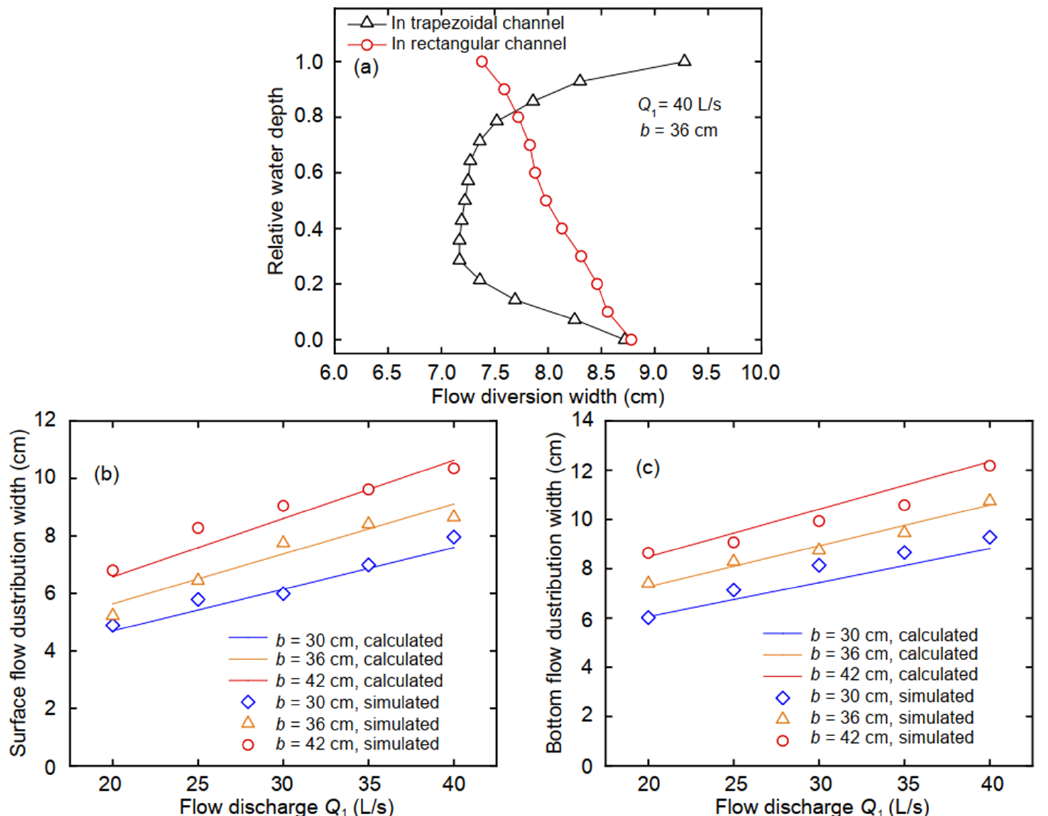
Figure 10. ( a ) Comparison of flow diversion widths in the trapezoidal and rectangular channels and comparisons of the calculated and simulated values of the flow diversion width for ( b ) surface flow and ( c ) bottom flow.